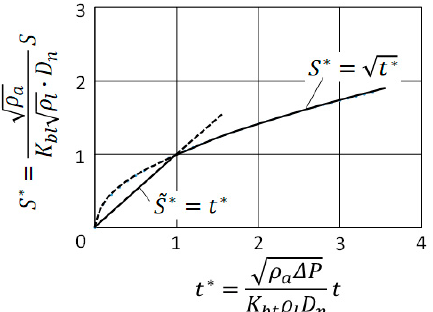
Figure 5. Normalized expression of spray tip penetration.